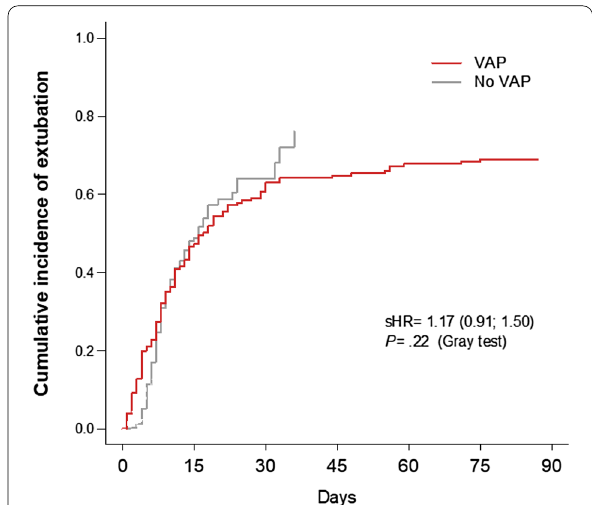
Fig. 3 Cumulative likelihood of MV weaning in patients with and without VAP. MV mechanical ventilation, VAP ventilator-associated pneumonia, sHR cause-specific hazard ratio (indicated with 95% confidence interval). day 0 indicates the date of intubation. Note that the curve of the no-VAP subgroup ends at day 36 of MV, since all patients without VAP had been extubated or had died at this time. For the VAP subgroup, the curve ends at day 89 of MV for the same